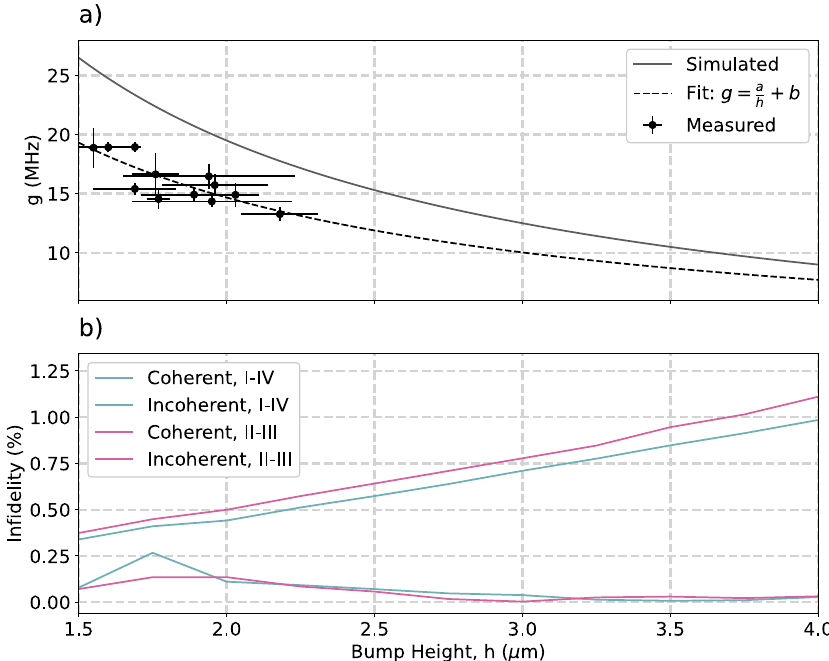
Fig. 2 Impact of post-bonding indium bump height on coupling rate and coherent and incoherent simulated gate errors. The fi t parameters in ( a ) are a = 27.9 ± 6.4 MHz μ m and b = 0.7 ± 3.5 MHz. The discrepancy between measurement and simulation and details on bump height measurements are discussed in the Methods section. There are only two distinct entangled qubit pairs in the designed Hamiltonian, the II – III and I – IV pairs as shown in Fig. 1b, both of which are simulated in ( b ). Error bars represent the measurement uncertainty on the bump height ( x -axis) and coupling rate ( y